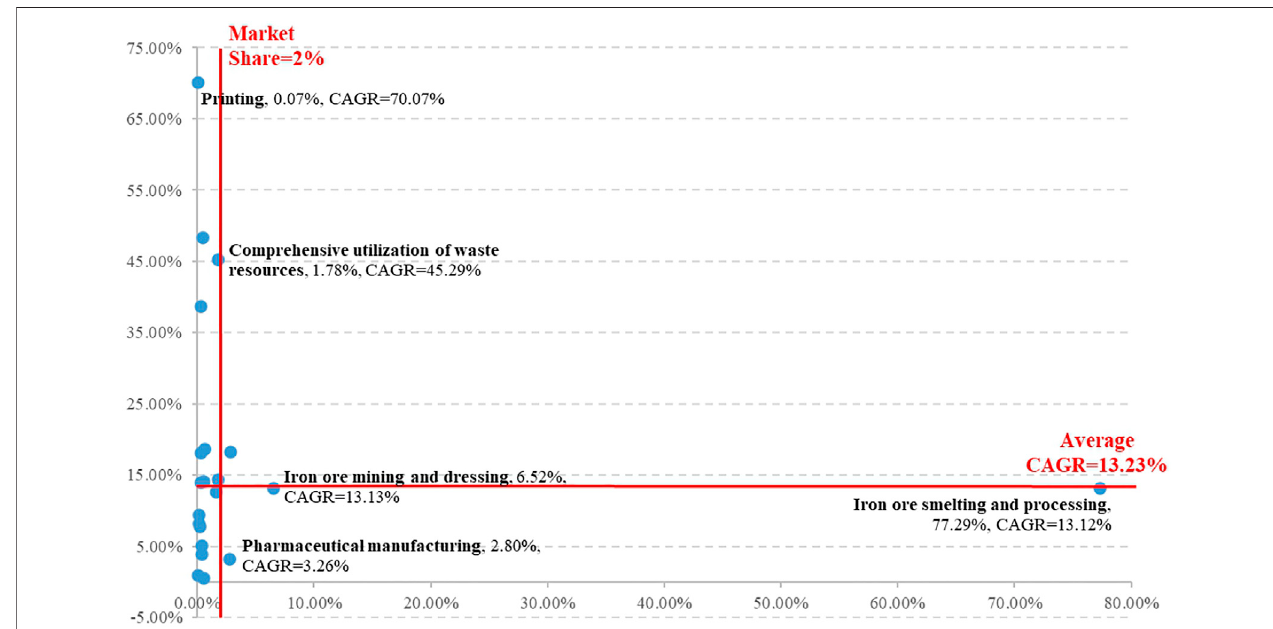
FIGURE 3 | Boston matrix of industrial output value, Benxi, 2016-2020. Data source: Benxi Statistical Yearbook, 2001-2020